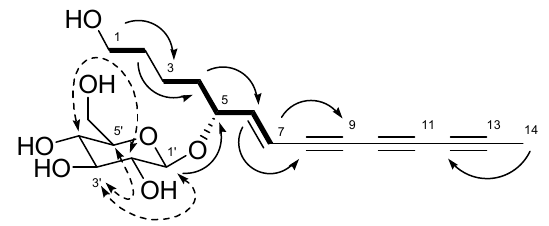
Figure 2. Key 1 H- 1 H COSY ( – ), 1 H- 1 H NOESY (----), and 1 H- 13 C HMBC ( → ) correlations of 1 . Table 1. 1 H-NMR (500 MHz) and 13 C-NMR (125 MHz) spectral data (DMSO- d 6 , δ in ppm) of 1 isolated from Coreopsis lanceolata .